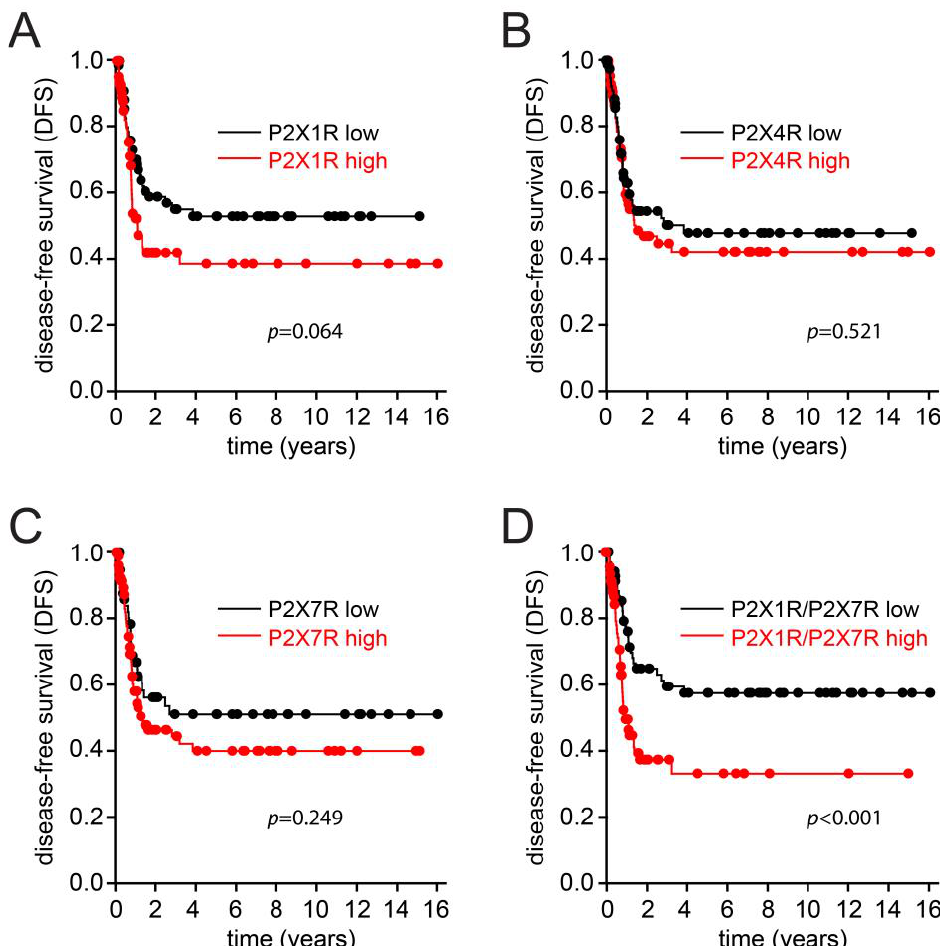
Figure 5. Effect of P2X receptor expression levels on disease-free survival (DFS) in muscle-invasive bladder cancer (MIBC). Expression of P2X1R ( A ), P2X4R ( B ), P2X7R ( C ), and combined expression of P2X1R and P2X7R ( D ) was immunohistochemically analyzed in MIBC and scored as “low” (below median) or “high” (above median). Kaplan–Meier disease-free survival (DFS) curves were plotted, and groups were compared by the log-rank test; ( A , B ): n = 171; ( C ): n = 172; ( D ): n =